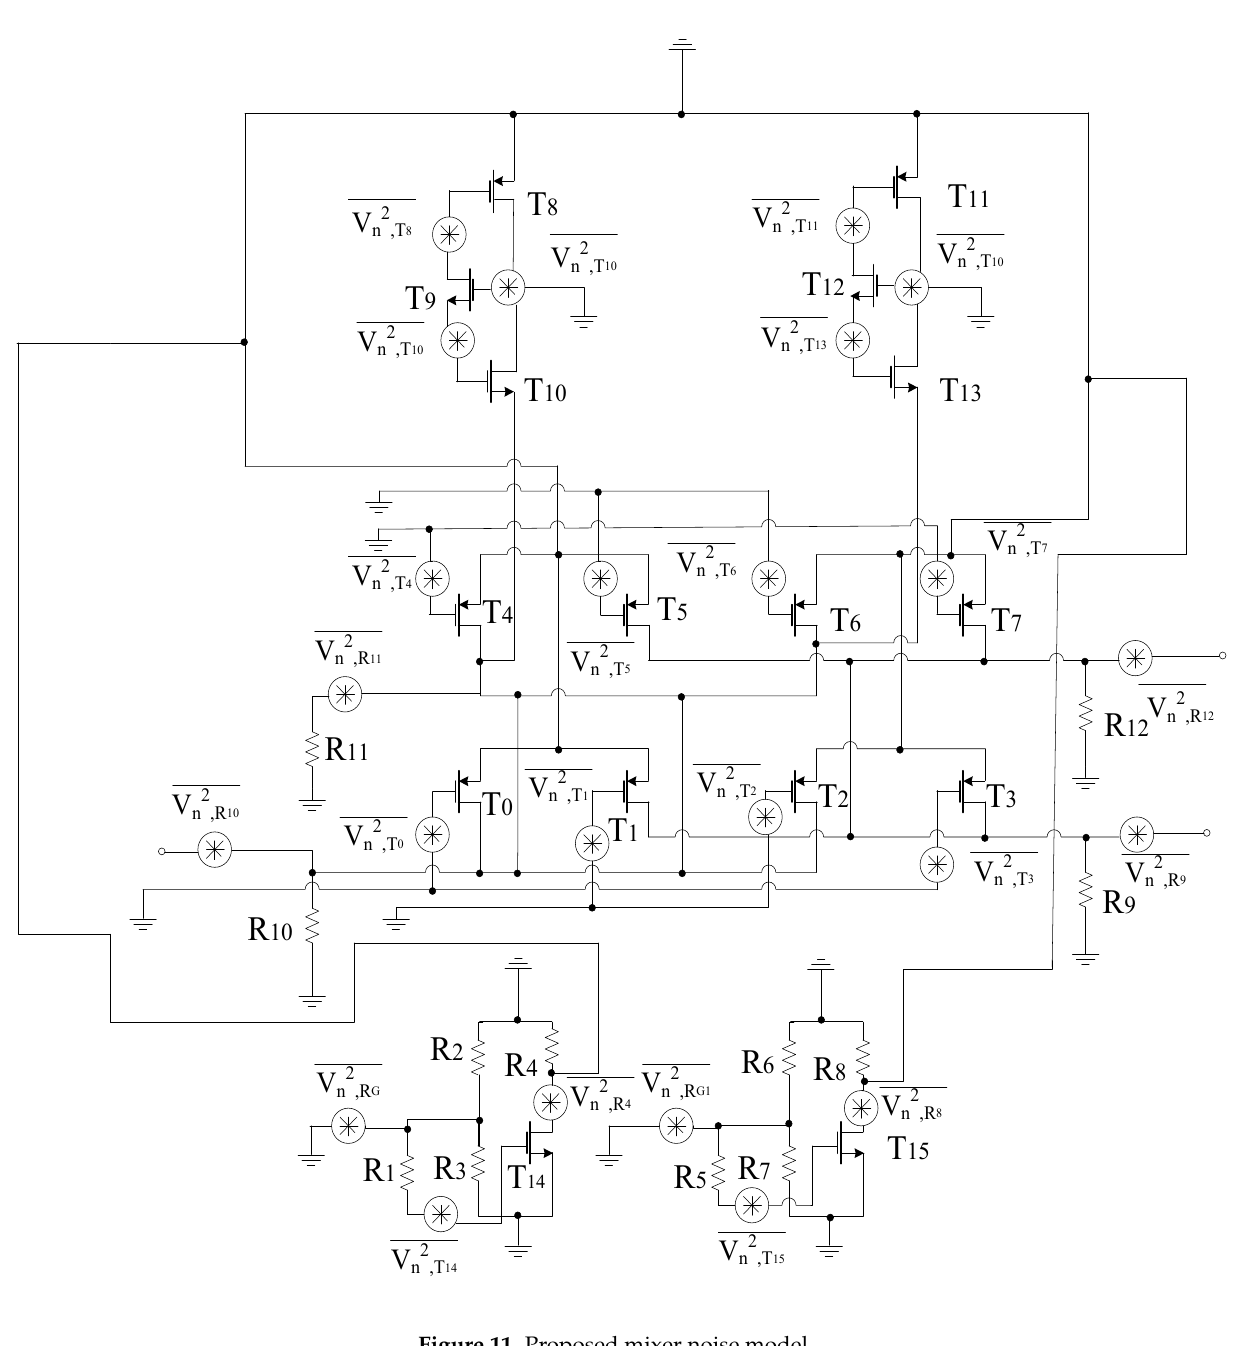
Figure 11. Proposed mixer noise